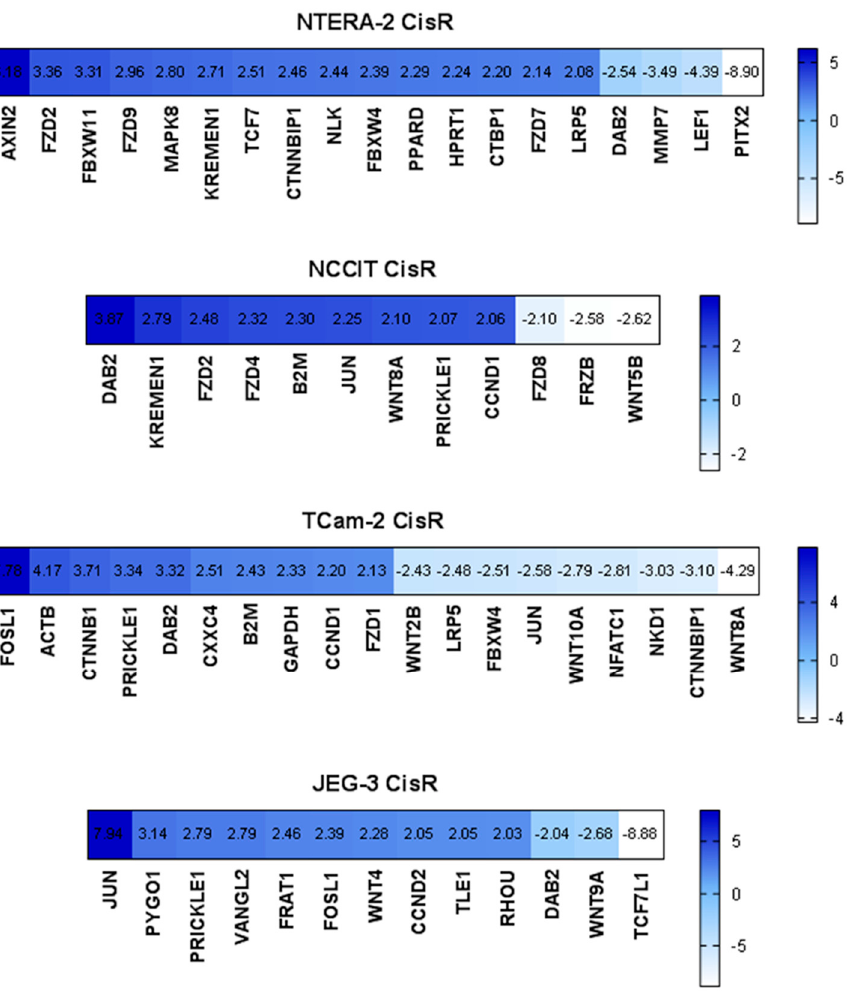
Figure 1. Expression analysis via RT 2 Profiler™ PCR Array Human WNT Signaling Pathway revealed significant down- and upregulation of several genes in cisplatin-resistant GCT cell lines compared to parental cells. Visualization of fold regulation of altered genes is shown.